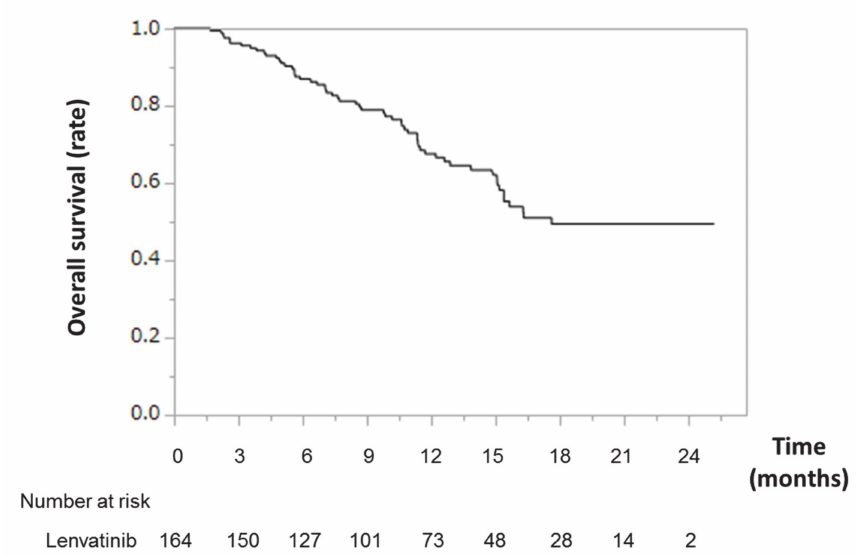
Figure 1. Overall survival time in patients with HCC treated with lenvatinib. Kaplan–Meier curves for overall survival time in patients with HCC treated with lenvatinib. Abbreviations: HCC, hepatocellular carcinoma.